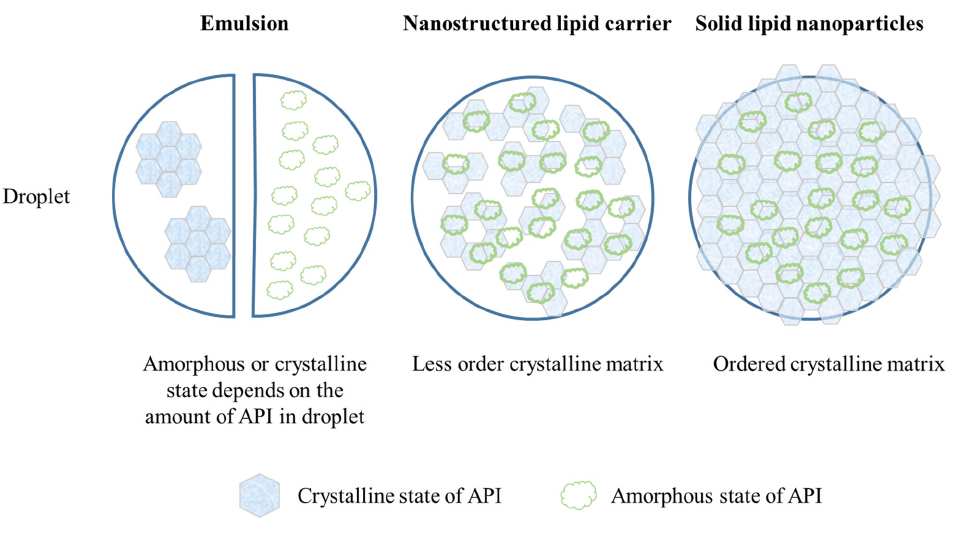
Figure 11. Illustration of a lipid-based formulation.